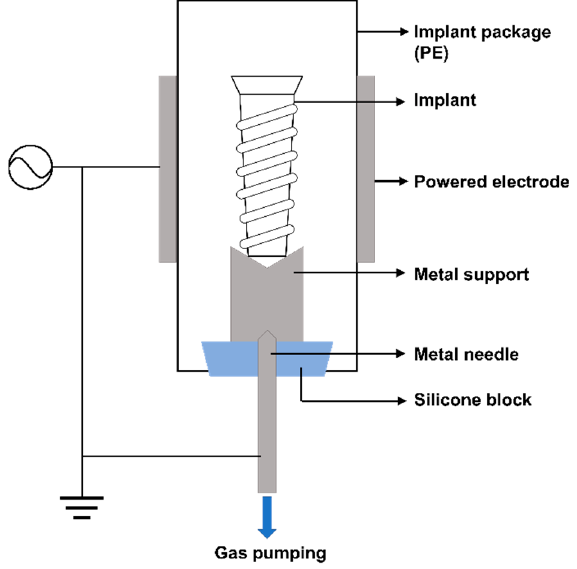
Figure 1. Schematic of the plasma generator